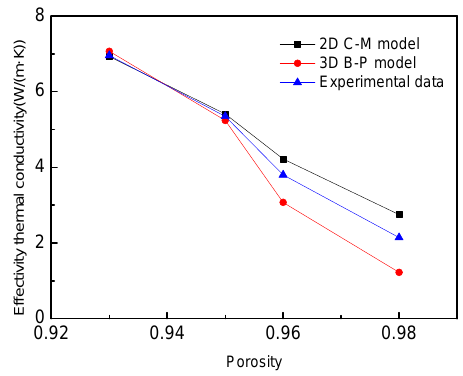
Figure 6. The numerical and experimental results of the effective thermal conductivity.